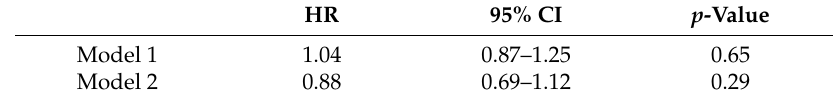
Table 3. Association of hepcidin per one SD increase with CV death during 4 years of